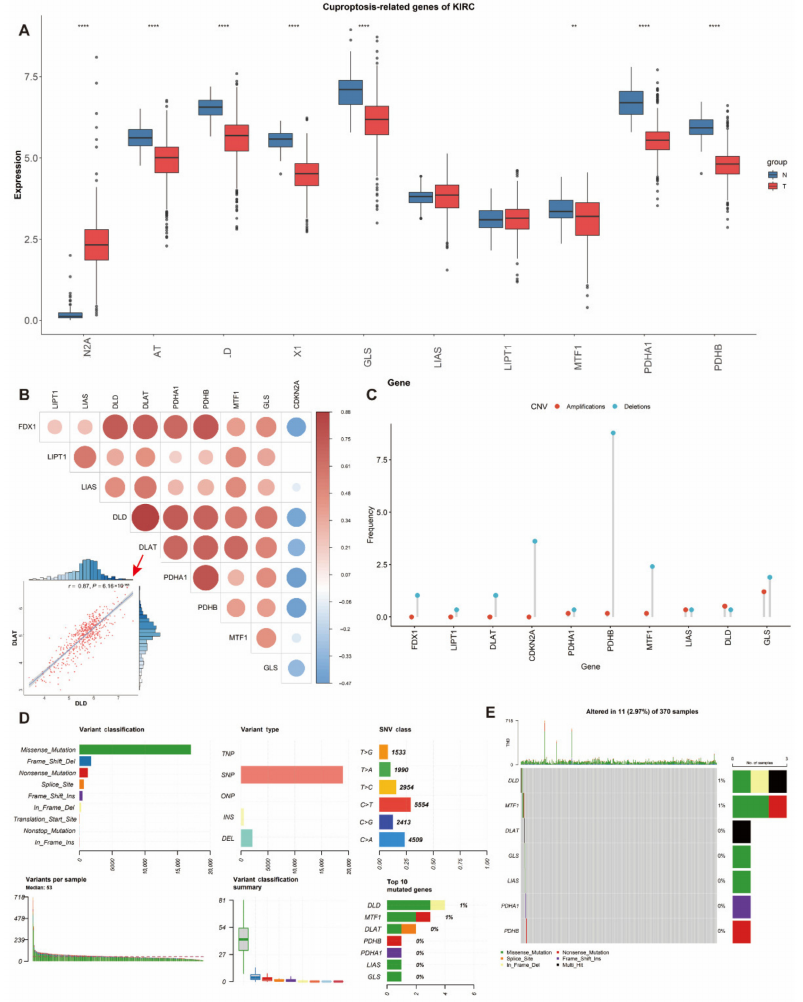
Figure 1. Expression and genetic alteration of CRGs in ccRCC: ( A ) the expression of 10 CRGs in ccRCC and normal tissues (tumor in red and normal in blue). The upper and lower ends of the boxes represent the interquartile range of values. The lines in the boxes represent the median value; ( B ) correlations between the expression of cuproptosis regulators; ( C – E ) the CNV and mutation frequency and classification of 10 CRGs in ccRCC. * p < 0.01, *** p < 0.001; CRG: cuproptosis-related gene, ccRCC: clear cell renal cell carcinoma, SNP: single nucleotide polymorphism, INS: insertion and DEL: